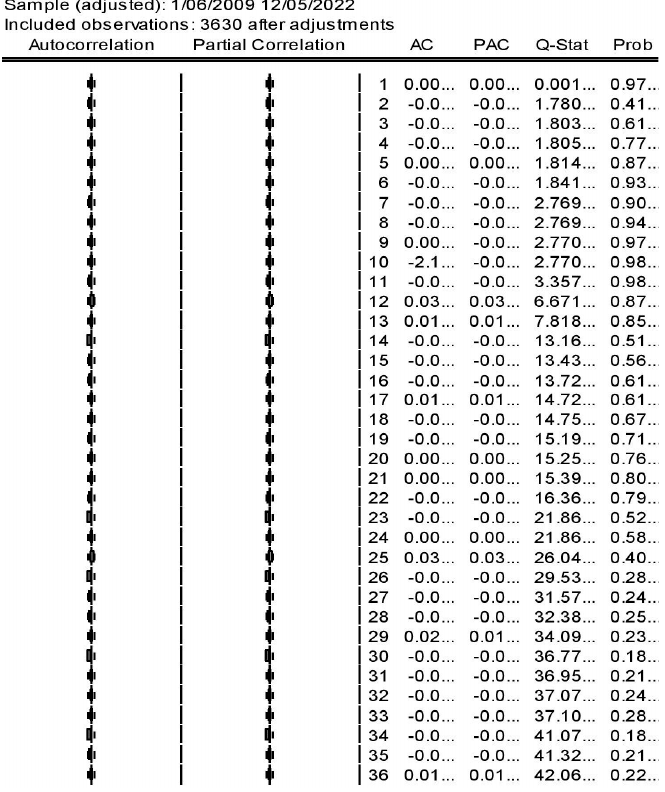
Figure 5. Correlogram plot of Residual series. Additionally, the unit root test for the residual series as shown in Table 5 confirms that the residuals are stationary as the p values are less than 0.05. To sum up, we can conclude that the residual diagnostics clearly indicate that the mean equation is correctly